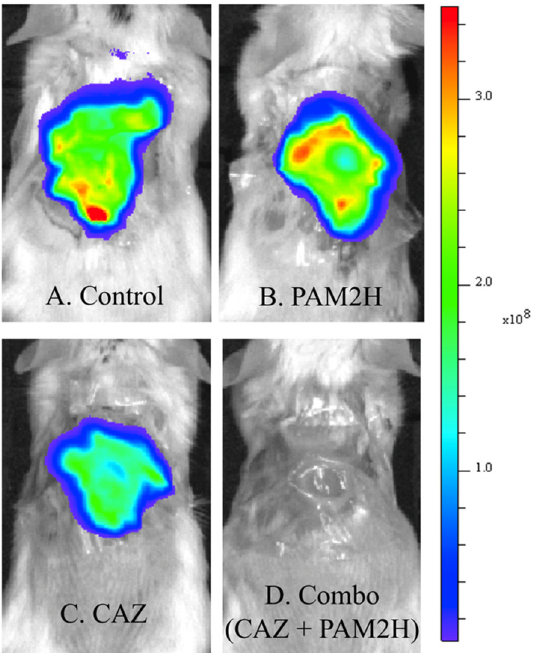
Figure 1. IVIS images showing the radiance (p/s/cm 2 /sr) of PAO1:: lux bacteria in dorsal wounds of mice on day 4 post-surgery after completion of treatments. ( A ). IVIS of a mouse from the control- treated group receiving only PBS, ( B ). PAM2H (phage cocktail) only treated group, ( C ). CAZ only treated group, ( D ). combination treated group receiving both PAM2H and CAZ.